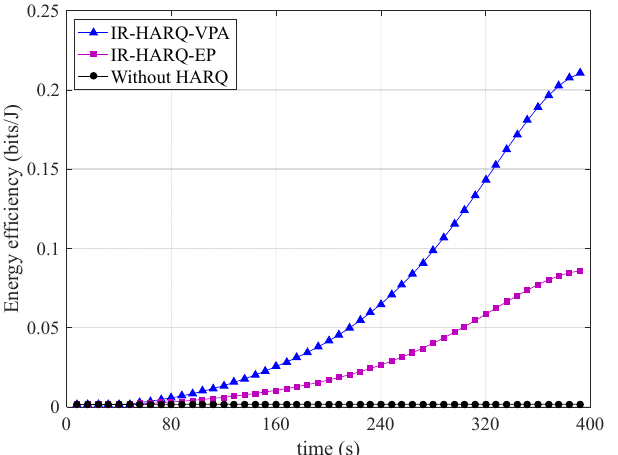
Figure 14. The energy efficiency of different transmission schemes in half of the communication window.